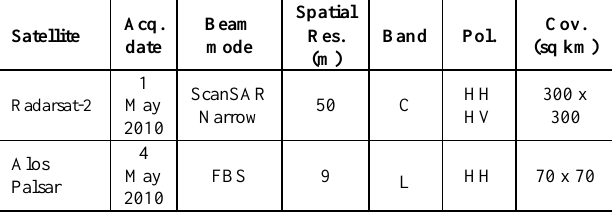
Table 1. The characteristics of the radar dataset used.